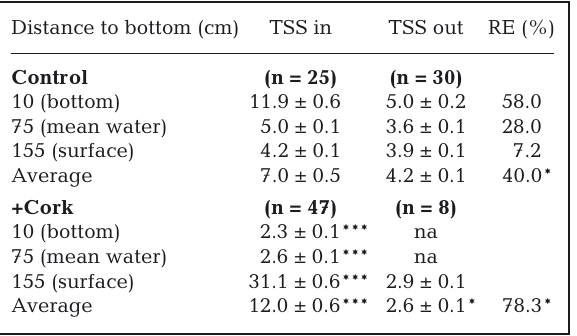
Table 5. Total suspended solids concentration (TSS, mg l −1 ) before and after the settling basin (control diet; sampling points SP3 and SP4, see Fig. 1) and surface separator outlet pipes (cork diet; SP2/SP4 and SP5, see Fig. 1) and associated removal efficiency (RE). Values are means ± SE. Values marked with asterisks are significantly different from the re - spective value of the control diet (***p < 0.0001, *p < 0.05). na: not applicable, as these were unfiltered counterparts remaining in the water column